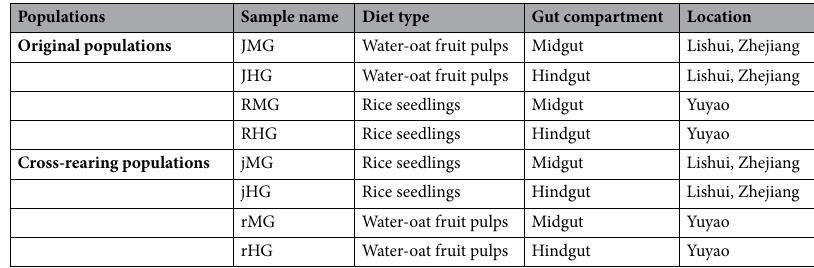
Table 1. Sample list of larvae C. suppressalis .